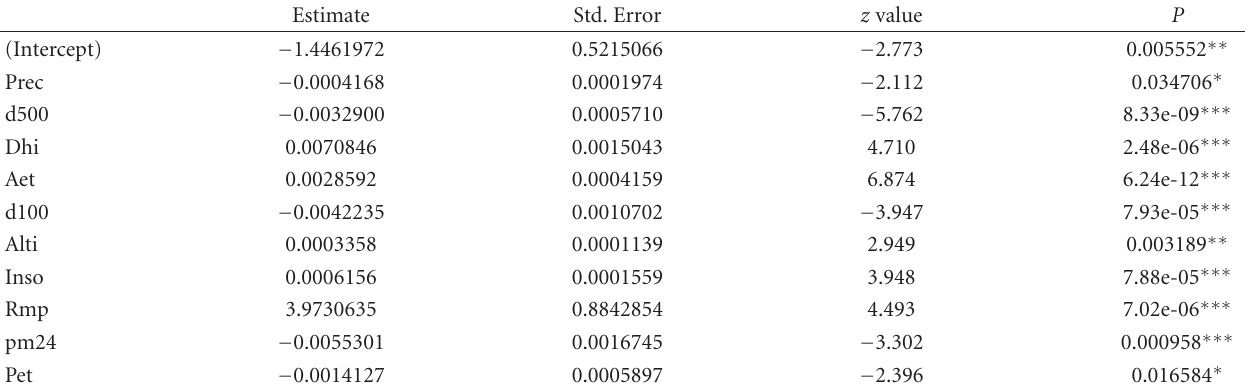
Table 4: Bufo calamita